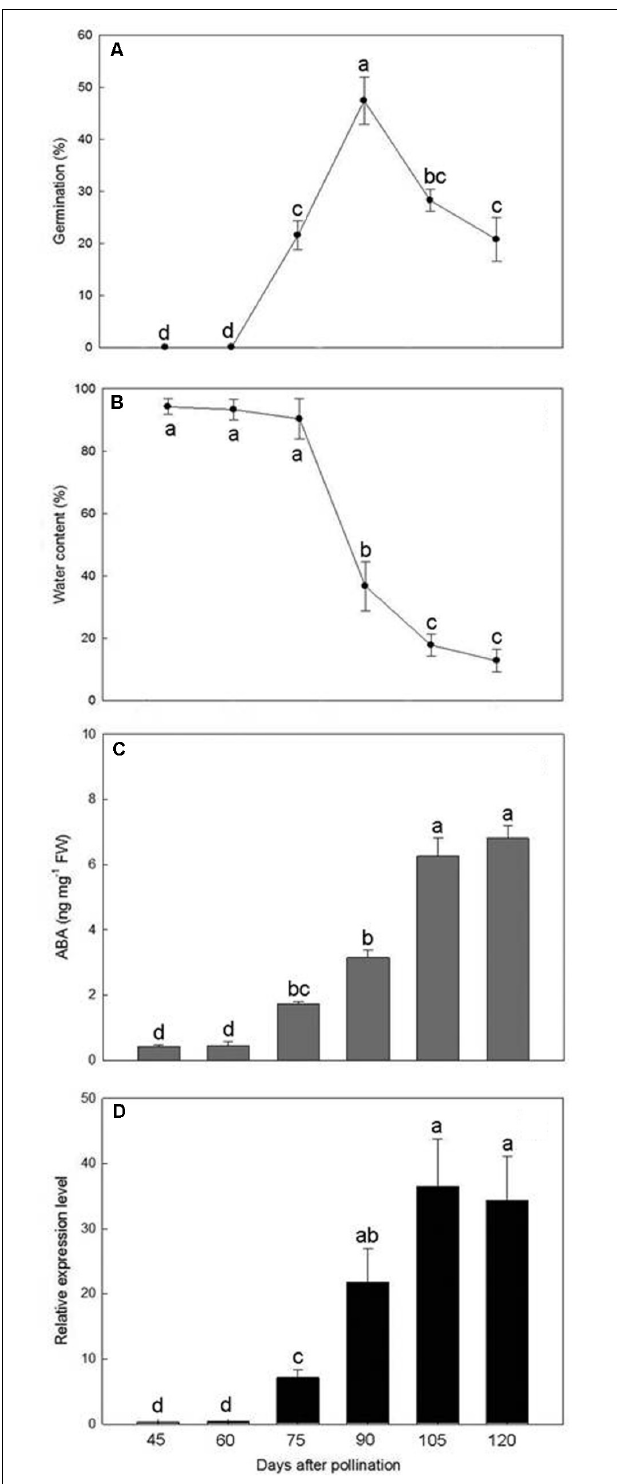
FIGURE 6 | Changes in germination percentage (A) , water content (B) , ABA content (C) , and PtNCED1 transcript level (D) in developing seeds. Data are mean ± SD from three biological replicates. Bars labeled with the same letter are not significantly different at P ≤ 0.05 by Fischer’s protected LSD test.